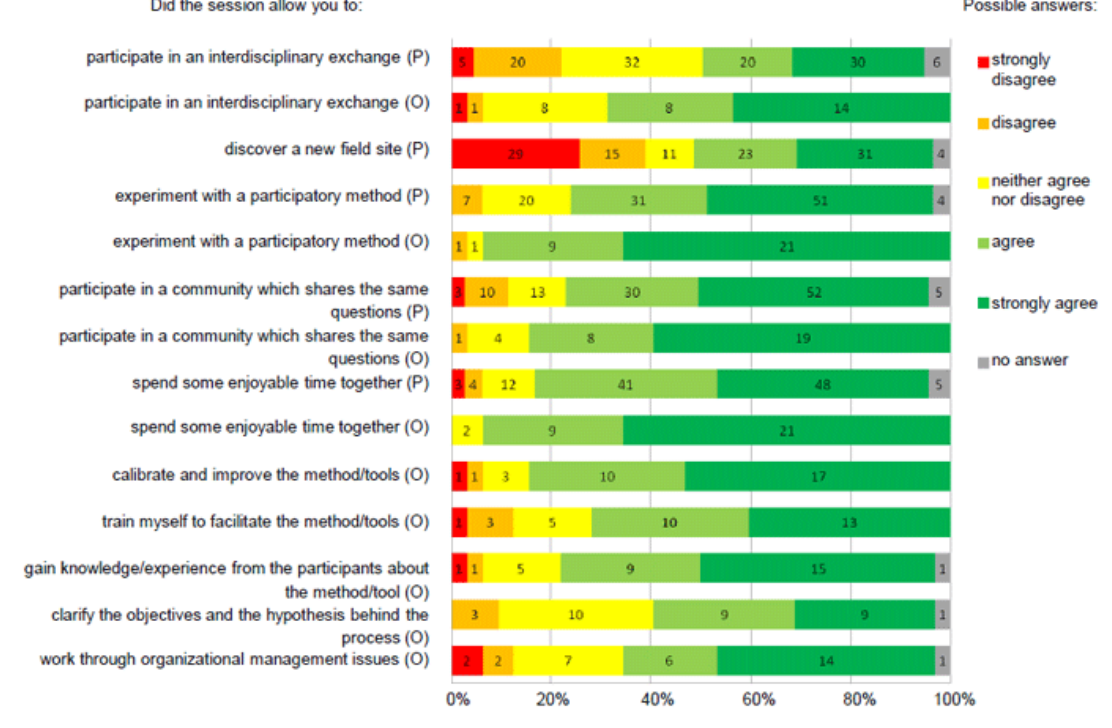
Fig. 2. Detailed results of the SCoP evaluation survey for participants (P) and organizers (O). The numbers on the bars are the number of respondents replying to each answer